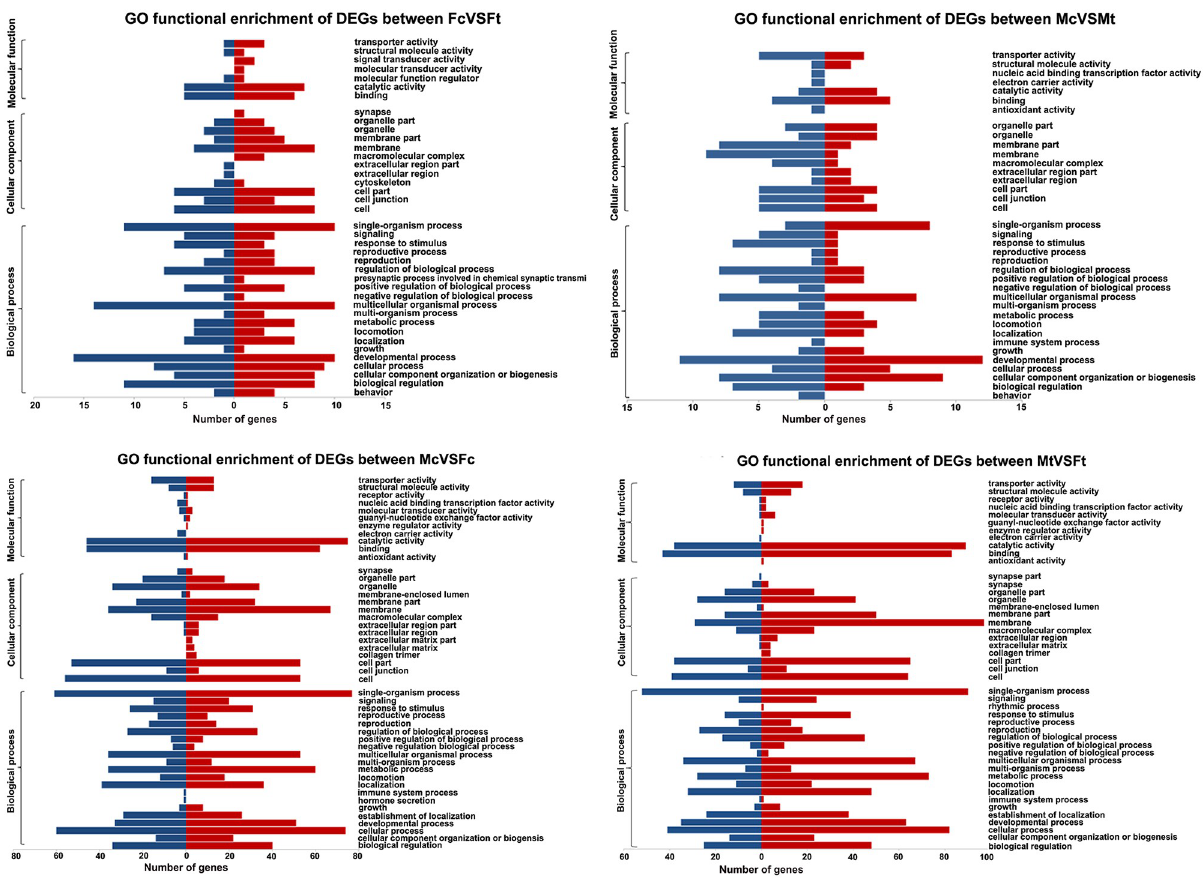
Fig 2. Gene Ontology (GO) enrichment analysis of differentially expressed genes between samples. Upregulated genes in enriched GO terms are indicated by red bars, and those with downregulated expression are indicated in blue. FcVSFt; female control versus female DXM treated, MtVSFt; male DXM treated versus female DXM treated, McVSFc; male control versus female control, McVSMt; male control versus male DXM treated.